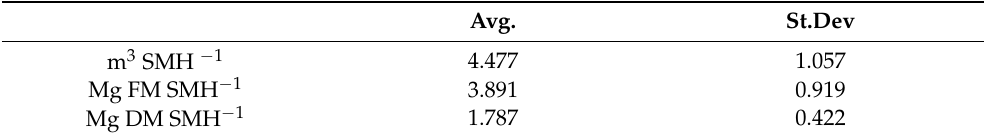
Table 4. Work productivity SMH (including delays) for chipping operation.